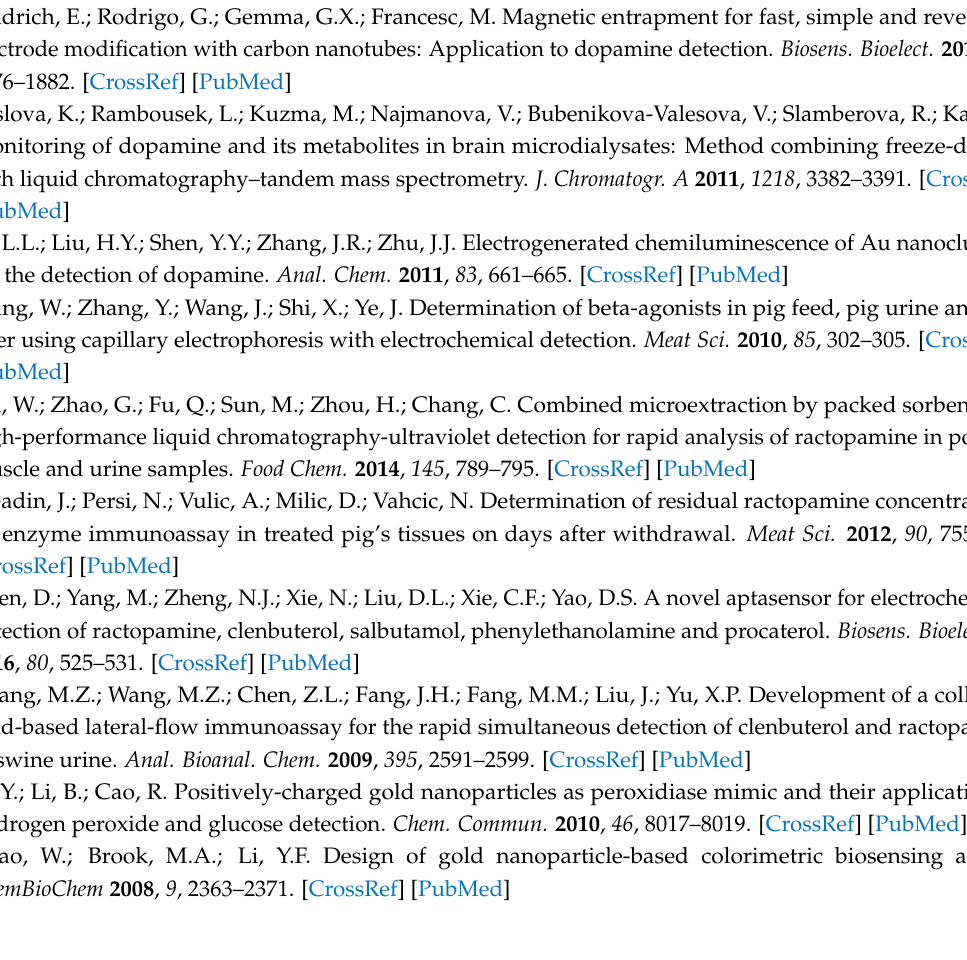
Table S1: Results of FT-IR and UV-VIS of SiW 11 M, SiW 10 M 2 , and SiW 9 M 3 (M = Co 2+ , Fe 3+ , Cu 2+ , Mn 2+ ). Figure S1: FT-IR spectra of SiW 9 M 3 (M = Co 2+ , Fe 3+ , Cu 2+ , Mn 2+ ). Figure S2: XRD patterns of SiW 9 M 3 (M = Co 2+ , Fe 3+ , Cu 2+ , Mn 2+ ), SiW 9 , SiW 10 , SiW 11 , and SiW 12 . Figure S3: XPS spectra of SiW 9 M 3 (M = Co 2+ , Fe 3+ , Cu 2+ , Mn 2+ ). Survey (a) high-resolution of Co 2p (b), Cu 2p (c), Fe 2p (d), and Mn 2p (e). Preparation of catalysts